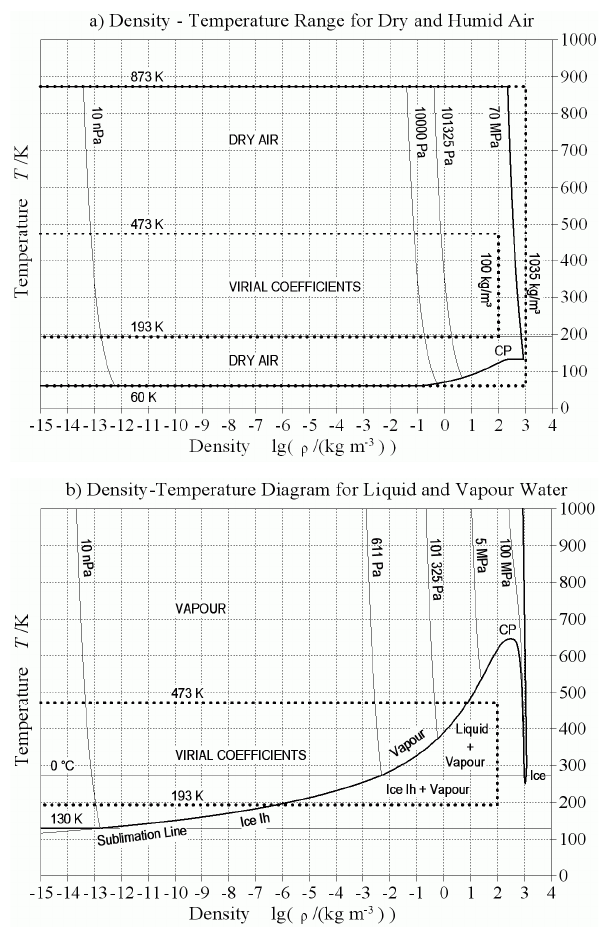
Fig. 9. Panel (a) : Validity ranges of the Helmholtz function for hu- mid air overlain on the phase boundary diagram for dry air. The region indicated by the outer heavy dotted lines gives the range boundaries implemented in the library for dry air ( A precisely equal to one). Below the dewpoint curve in the lower right portion of the diagram, dry air condenses. This region below 150K at high den- sity is irrelevant to oceanographic or meteorological applications but is not excluded by our range checks. To consider humid air, virial coefficients are required. The validity range in temperature of the limiting third virial coefficients is indicated by the bold dotted lines enclosing the words “VIRIAL COEFFICIENTS” in panels (a) and (b). Comparisons with experimental data show good agreement with saturated partial pressures up to a density of 100kgm − 3 ; this density is chosen as the upper bound on the validity range for hu- mid air. Panel (b) : The validity range of the Helmholtz function for humid air overlain on the phase boundary diagram for fluid water. Evidently, the upper validity boundary on density is determined by saturation, i.e. the partial transition of vapour to ice or liquid water (the two phase region) rather than the boundary for the validity of the cross-virial